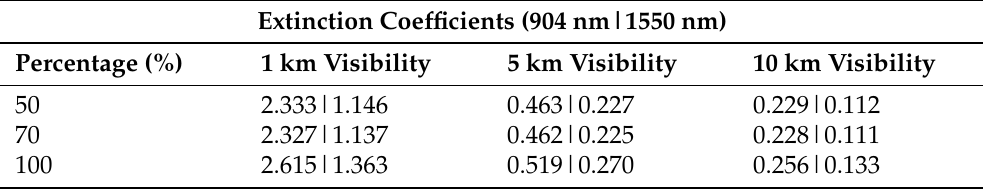
Table 2. A list of extinction coefficients for 905 nm and 1550 nm wavelengths subjected to varying levels of humidity.